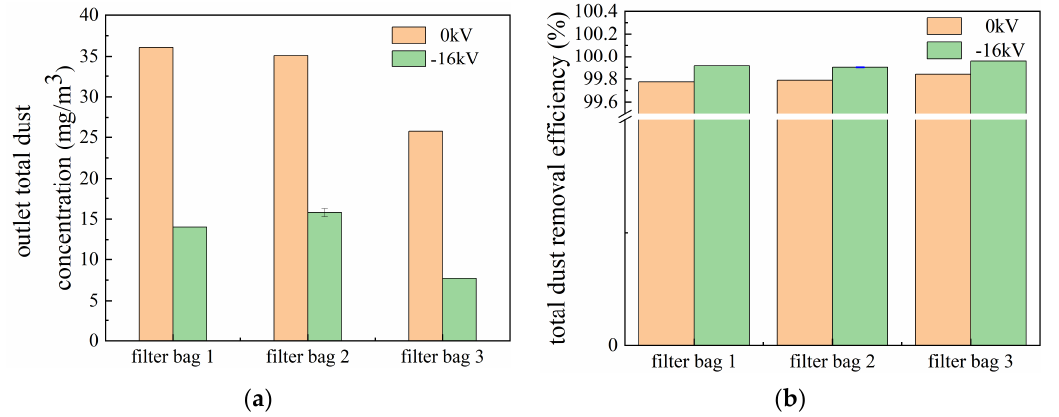
Figure 5. Total dust removal performance of the dust collectors: ( a ) total dust concentration; ( b ) dust removal efficiency.